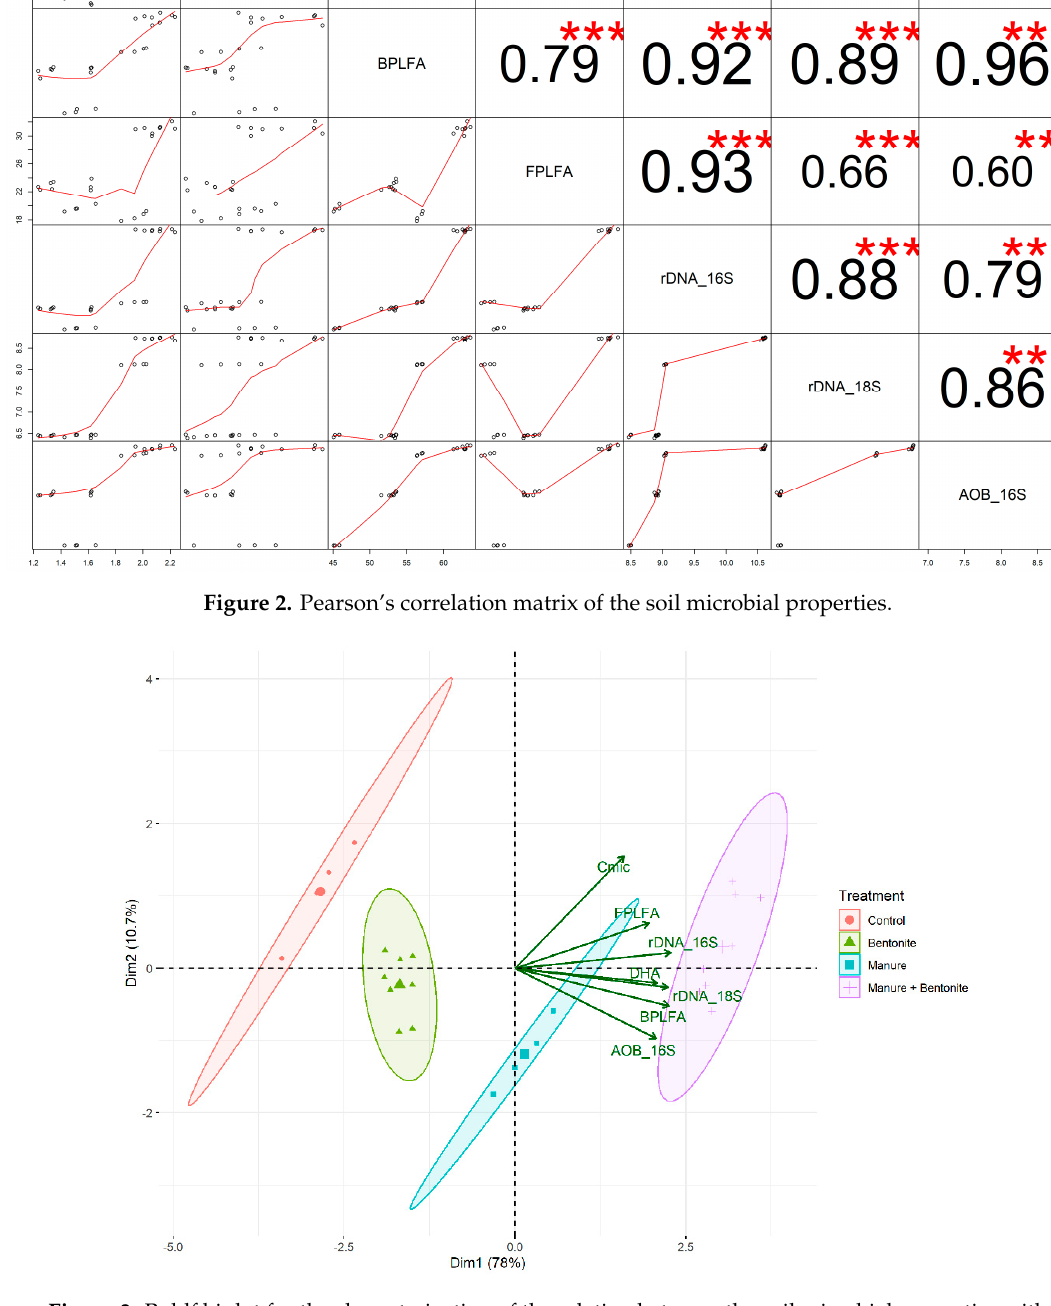
Figure 3. Rohlf biplot for the characterization of the relation between the soil microbial properties with dependence on the